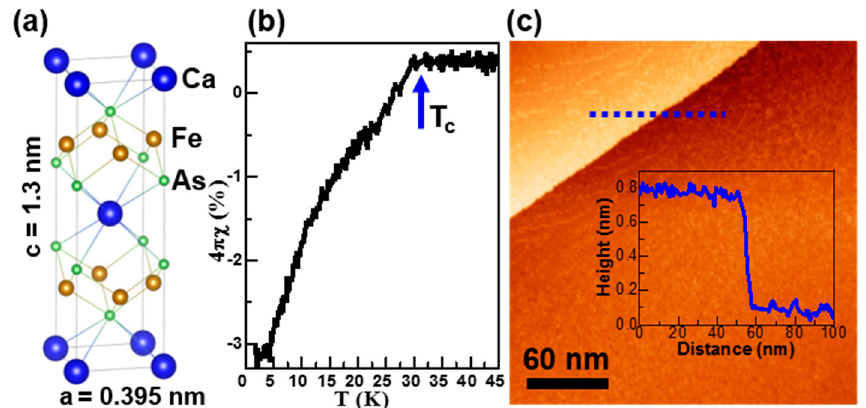
Figure 1. ( a ) Crystal structure of Ca122. ( b ) Temperature dependence of zero-field-cooled magnetic susceptibility of the sample of Pr-Ca122, showing diamagnetism below ~30 K, under a constant magnetic field of 20 Oe. ( c ) Large scale STM topographic image after cleaving (sample bias V S = − 20 mV, tunneling current It = 100 pA, temperature T = 4.2 K). The line profile across a half unit cell step is shown at the inset.